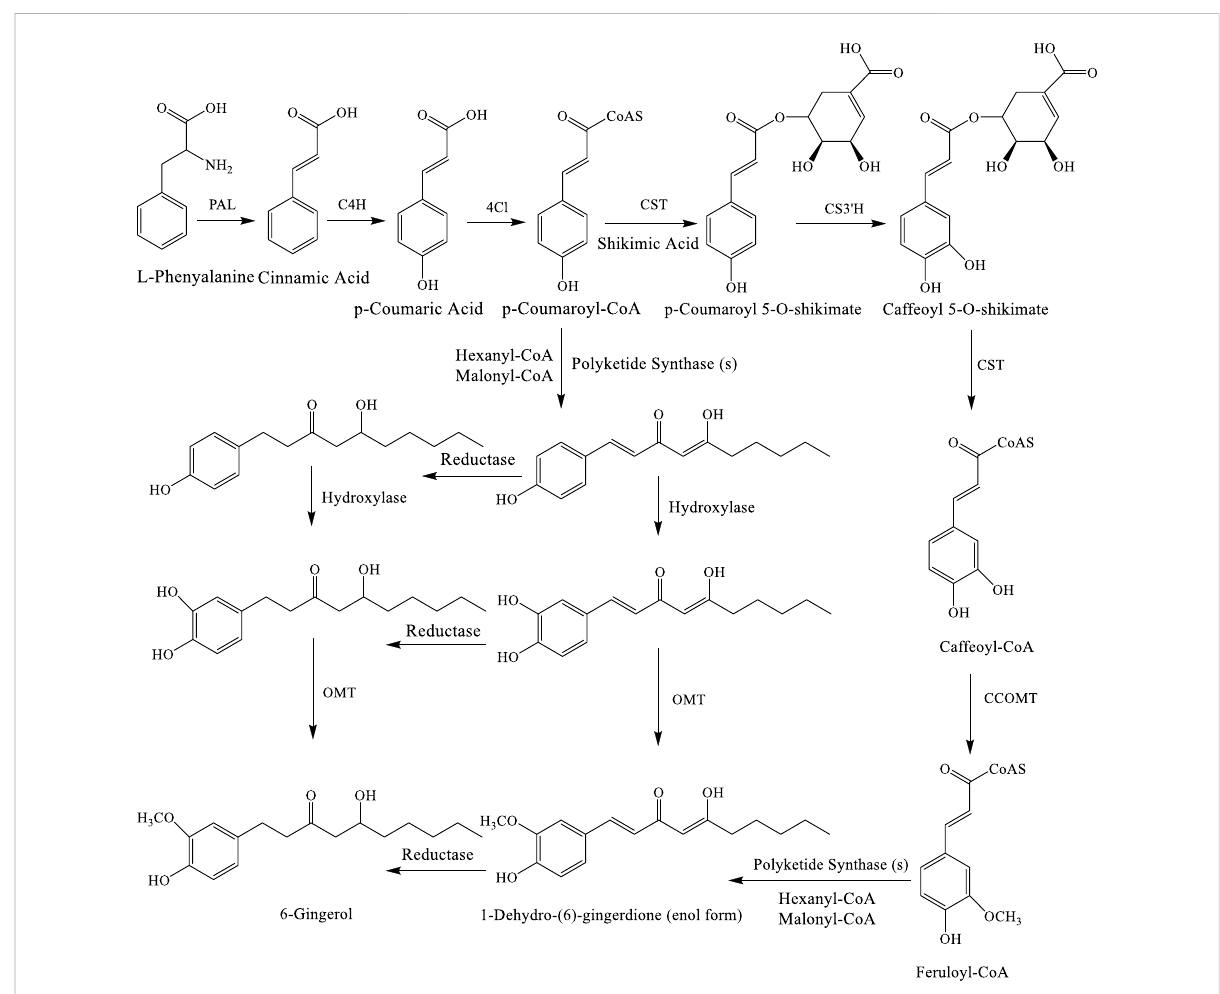
FIGURE 3 Alternative biosynthetic pathways for 6-gingerol. Enzymes: PAL, phenylalanine ammonialyase; C4H, cinnamate 4-hydroxylase; 4CL, 4- coumarate: CoA ligase; CST, p-coumaroyl shikimate transferase; CS3 ′ H, p-coumaroyl 5-O-shikimate 3 ′ -hydroxylase; OMT, O-methyltransferase; and CCOMT, caffeoyl-CoA O-methyltransferase. L-phenylalanine is converted into cinnamic acid via PAL. Next, it is turned into p-coumaric acid with the use of C4H. 4CL is then used to get p-coumaroyl-CoA. CST is the enzyme that is responsible for the binding of shikimic acid and p-coumaroyl-CoA. The complex is then selectively oxidized at C3 by CS3 ′ H to alcohol. Upon further reaction with CST, shikimate dissociates from this intermediate, thereby yielding caffeoyl-CoA. To achieve the desired substitution pattern on the aromatic ring, CCOMT converts the hydroxyl group at C3 into methoxy as seen in feruloyl-CoA. 1-Dehydro-(6)-gingerdione and then 6-gingerol are formed from feruloyl-CoA by the enzyme polyketide